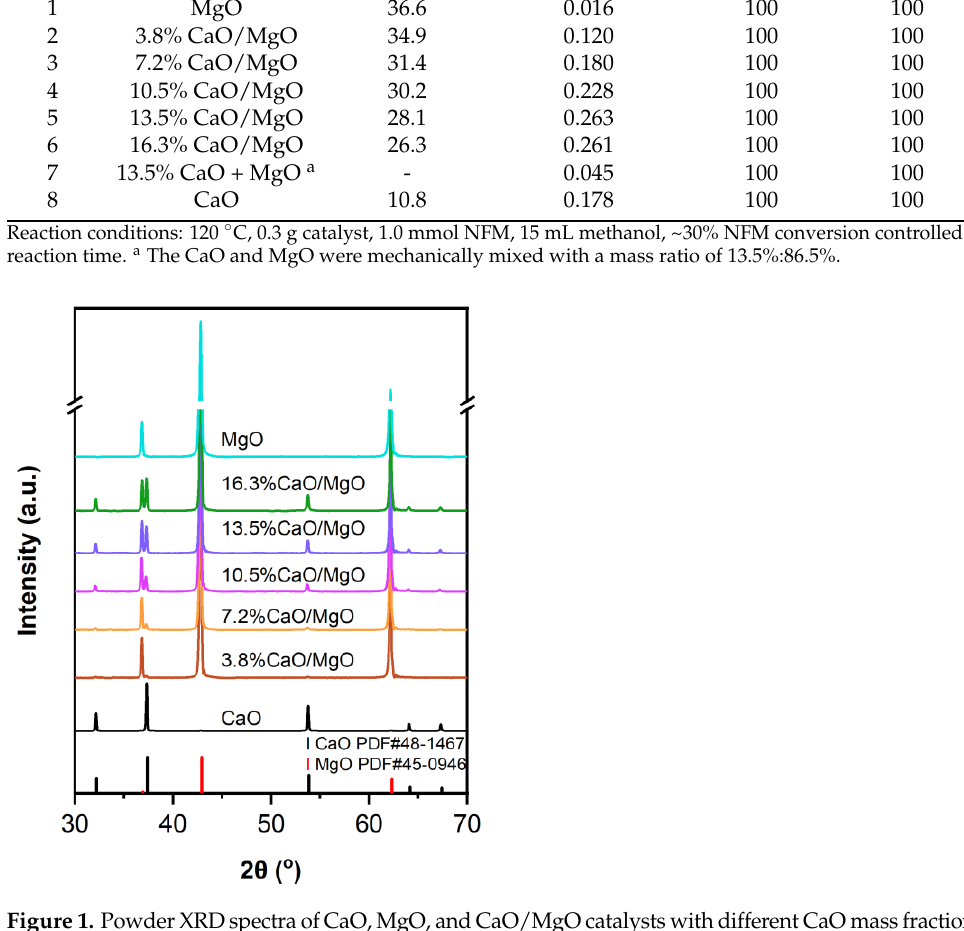
Figure 1. Powder XRD spectra of CaO, MgO, and CaO/MgO catalysts with different CaO mass frac- tions.